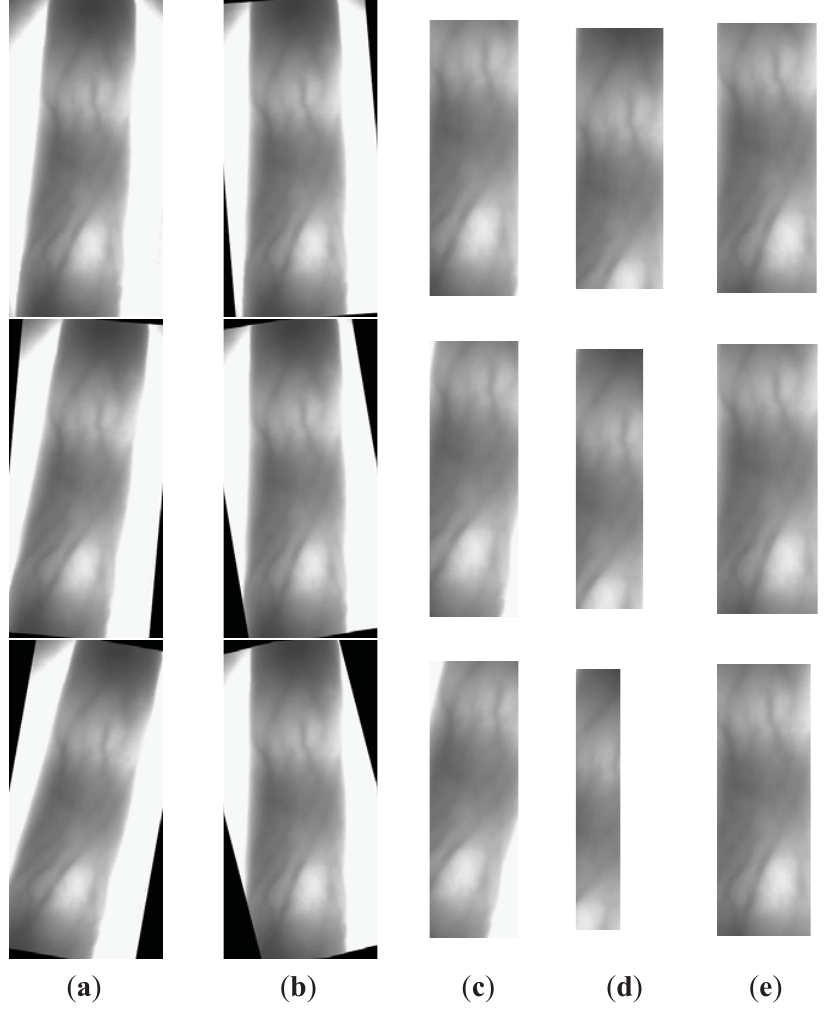
Figure 9. The effect of skewed image correction. ( a ) The skewed finger vein images. ( b ) The corrected finger vein images. ( c ) ROIs extracted by [5]. ( d ) ROIs extracted by [6]. ( e ) ROIs extracted by our